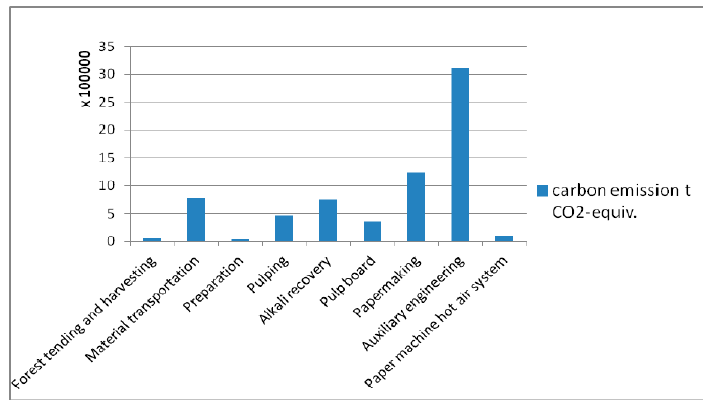
Figure 7. Carbon emission from energy consumption in production processes.